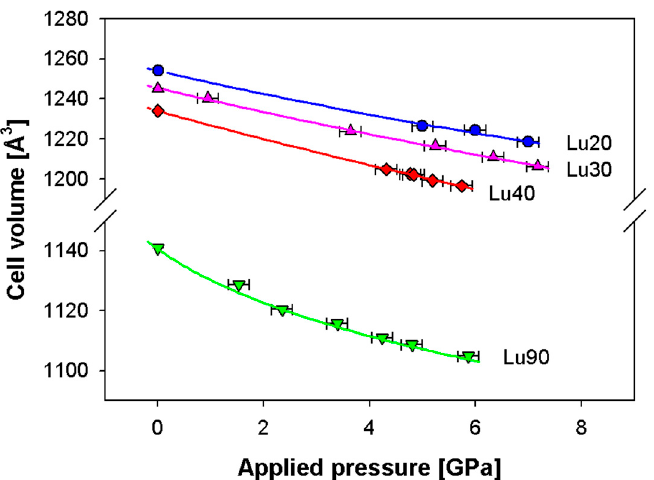
Figure 8. Dependence of the Lu-doped ceria cell volume vs. applied pressure; experimental data are taken from [13] and fitted by the third order Vinet EoS (continuous lines). Cell volumes of samples Lu20, Lu30 and Lu40 are multiplied by 8 in order to make them comparable with Sm90. Vertical error bars are hidden by data markers.